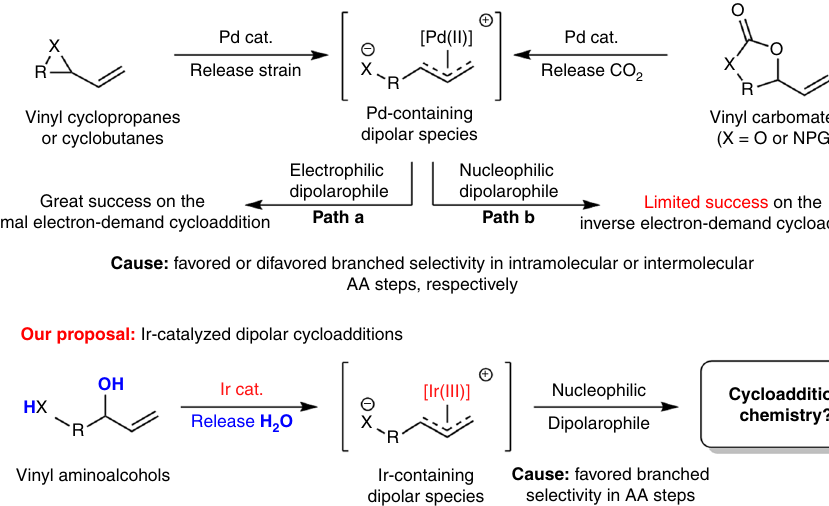
Fig. 1 Research proposal on the Ir-catalyzed cycloadditions of vinyl aminoalcohols. a Well-developed dipolar cycloadditions through asymmetric palladium catalysis and remained problem. b Dipolar cycloadditions through asymmetric iridium